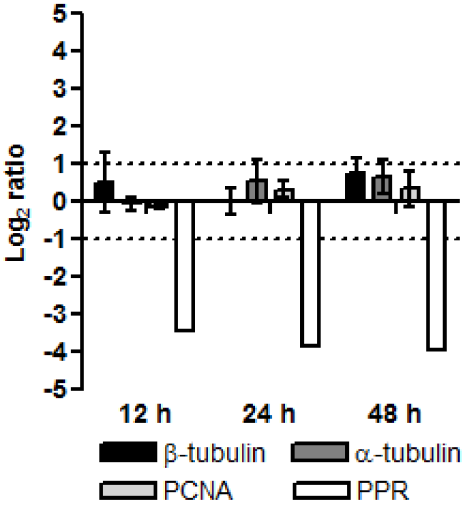
Figure 6. Stability of selected mRNAs following transcription inhibition assessed by qPCR. Triplicate cultures were treated with 2 m g ? mL 2 1 actinomycin D for 12, 24, or 48 h and the transcript abundance determined relative to DMSO carrier controls at each time point. Means 6 SD (n=3) are plotted. The PPR transcript was undetected in two of three replicates at 24 and 48 h following 40 PCR cycles, therefore SDs were not calculated. Dashed lines represent a 2-fold